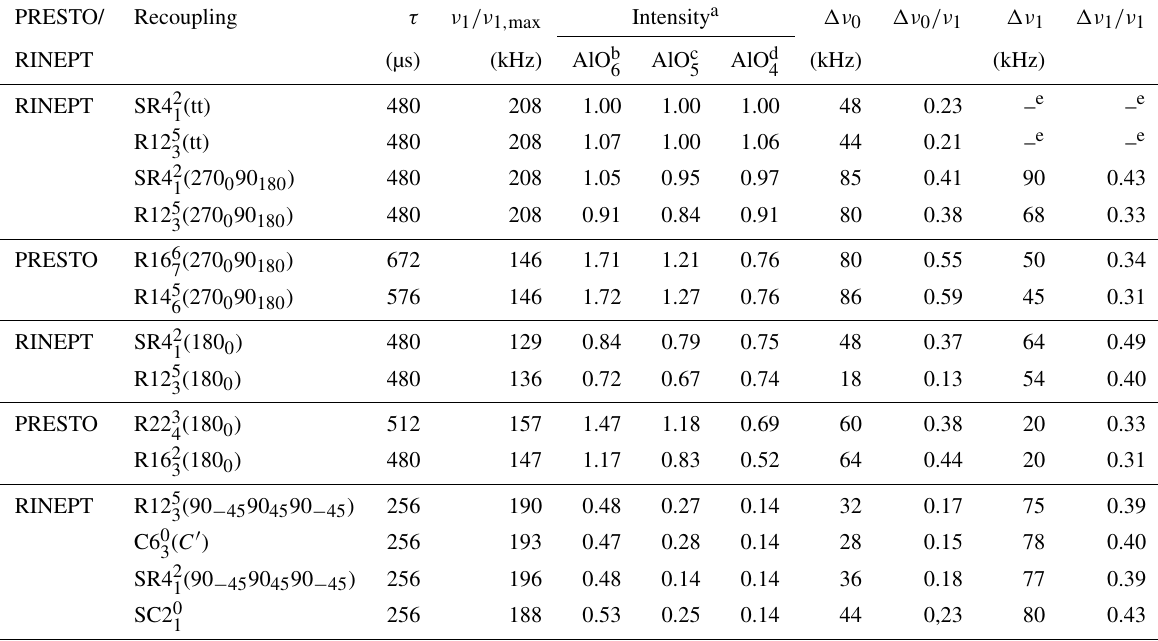
Table 4. Comparison of the performances of 1 H → 27 Al RINEPT-CWc and PRESTO transfers using various recouplings for AlPO 4 -14 at ν R = 62 .